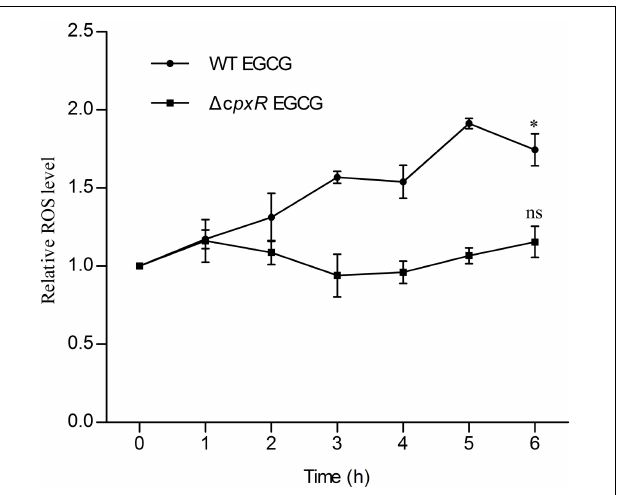
FIGURE 5 | Reactive oxygen species accumulation in WT and (cid:49) cpxR upon EGCG treatment. WT EGCG and (cid:49) cpxR EGCG represent WT and (cid:49) cpxR exposed to 1.6 mg/ml EGCG, respectively. ROS level was measured from 1 to 6 h. Cells, WT or (cid:49) cpxR , without EGCG treatment were used as controls. y axis represents the relative ROS level normalized by the average value of ROS level obtained for the control. All values were obtained from at least three biological replicates. Error bars indicate SD. ∗ P < 0.05. ns, not statistically